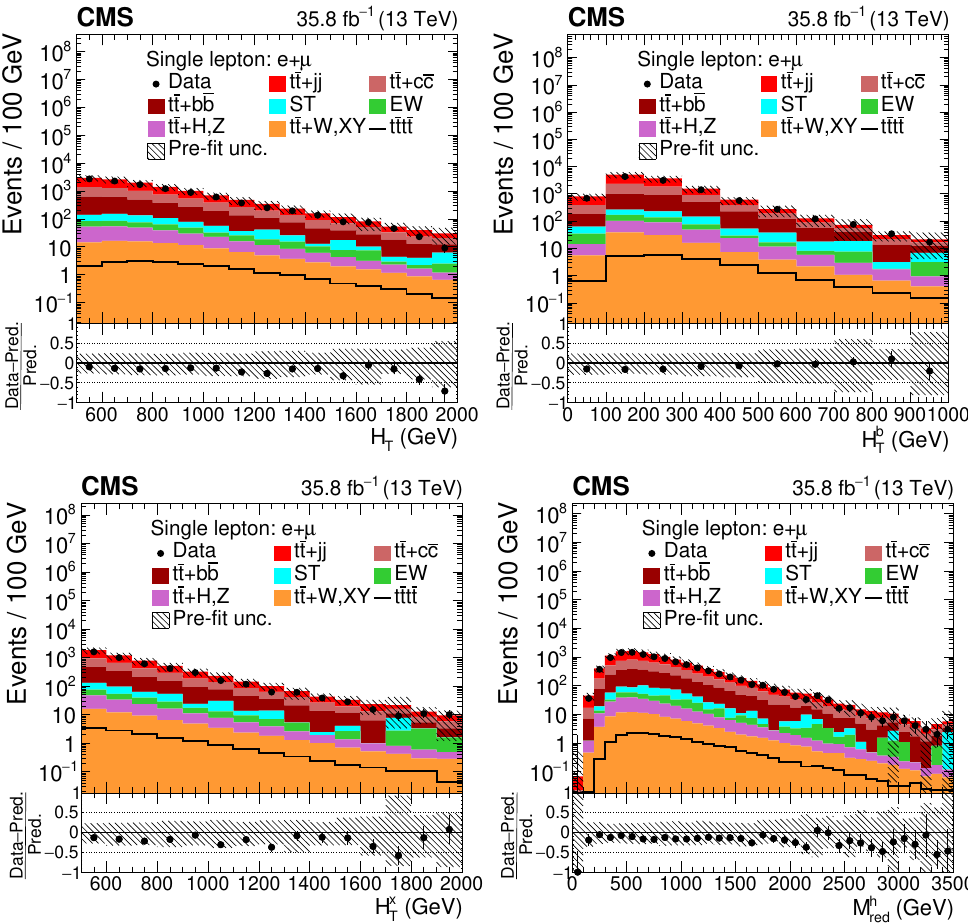
Figure 3 . Distributions of H , H b , H x and M h in the combined single-lepton channel. In T T red T the upper panels, the data are shown as dots with error bars representing statistical uncertainties, MC simulations are shown as a histogram. The lower panels show the relative di(cid:11)erence between the data and the sum of all of the standard model backgrounds. In each panel, the shaded band represents the total uncertainty in the dominant tt background estimate. See section 4.2 for the de(cid:12)nitions of the